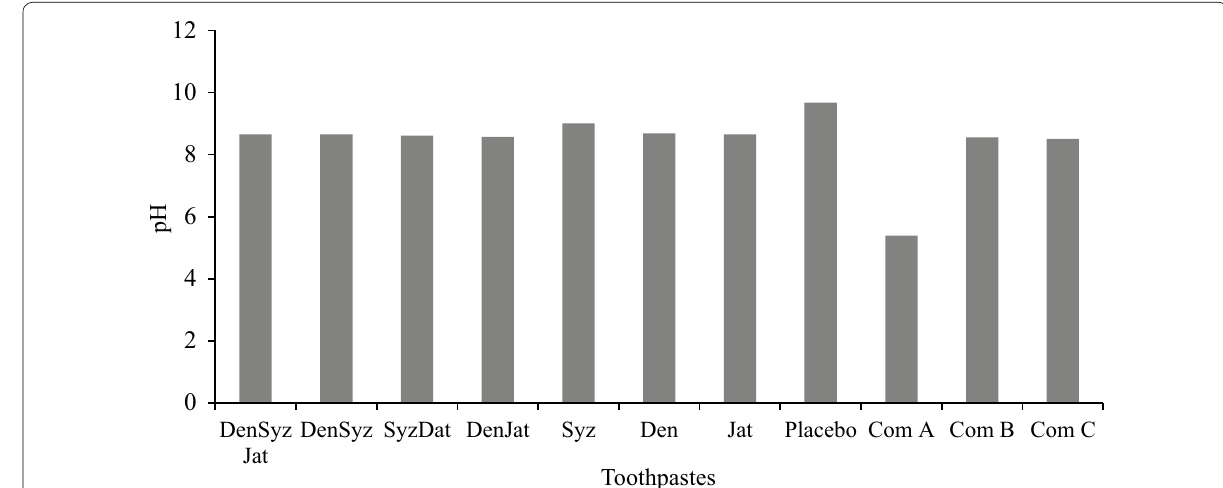
Fig. 1 pH of the formulated and commercial toothpastes. DenSyzJatlax-(Triarotex)— Dennettia tripetala, Syzygium aromaticum , Jatropha curcas latex mixture. DenSyz-(Triaro)— Dennettia tripetala, Syzygium aromaticum mixture. SyzJatlax(Arotex)— Syzygium aromaticum , Jatropha curcas latex mixture. DenJatlax-(Tritex)— Dennettia tripetala, Jatropha curcas latex mixture. Syz-(Aro)— Syzygium aromaticum mixture. Den-(Tri)— Dennettia tripetala . Jatlax-(Tex)— Jatropha curcas latex. Placebo-without plant extracts material. Commercial fluoride toothpaste—Com A. Commercial herbal toothpaste—Com B. Commercial ordinary toothpaste—Com